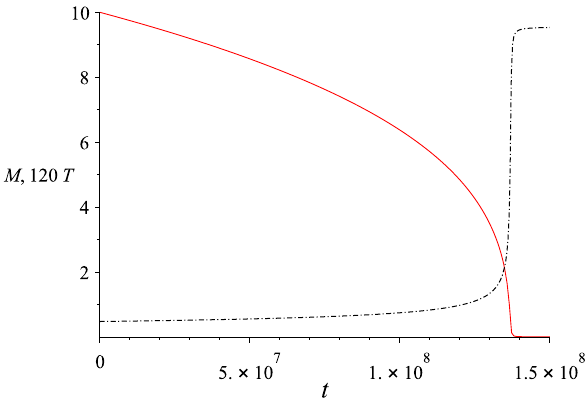
Fig. 2 The Hawking temperature of an asymptotically flat Schwarzschild black hole with α = − 1, here in black dash-dotted curve, as a function of time, shows that the temperature tends to a constant value. The mass of the black hole, in red solid curve, tends to zero asymptotically. In order to display both curves in the same diagram, we have multiplied the Hawking temperature by a factor of 120, so that the temperature curve tends to 120 T ∗ = 120 / 4 π ≈ 9 . √ α M p , as